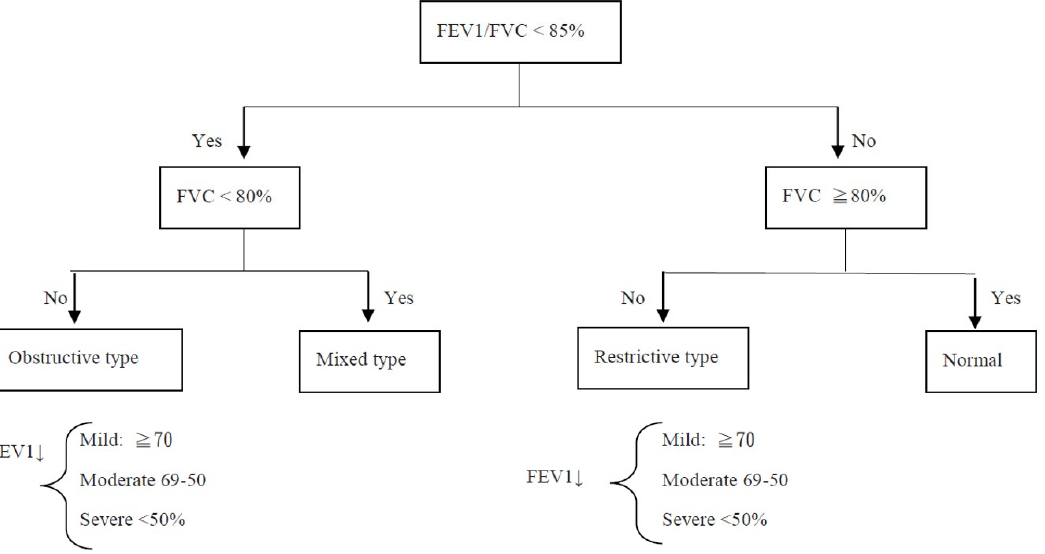
Figure 1. Interpretation of spirometry results. FVC: Forced vital capacity; FEV1: forced expiratory volume in the first second.